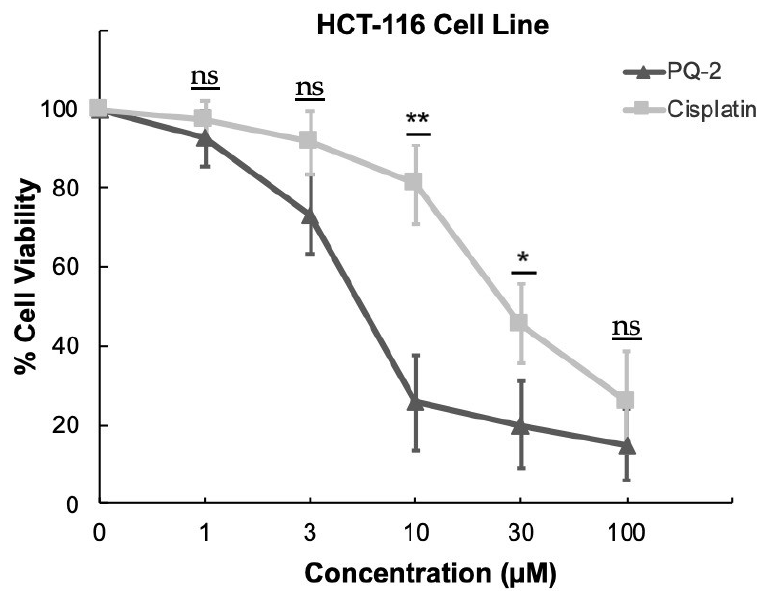
Figure 8. The anticancer effects of PQ2 and cisplatin at varying concentrations on HCT-116 cells. Data are representative of the mean of three separate experiments and are reported at the ± SD and p values were determined using Student’s t test (* p < 0.05, ** p < 0.01, ns: not statistically significant).